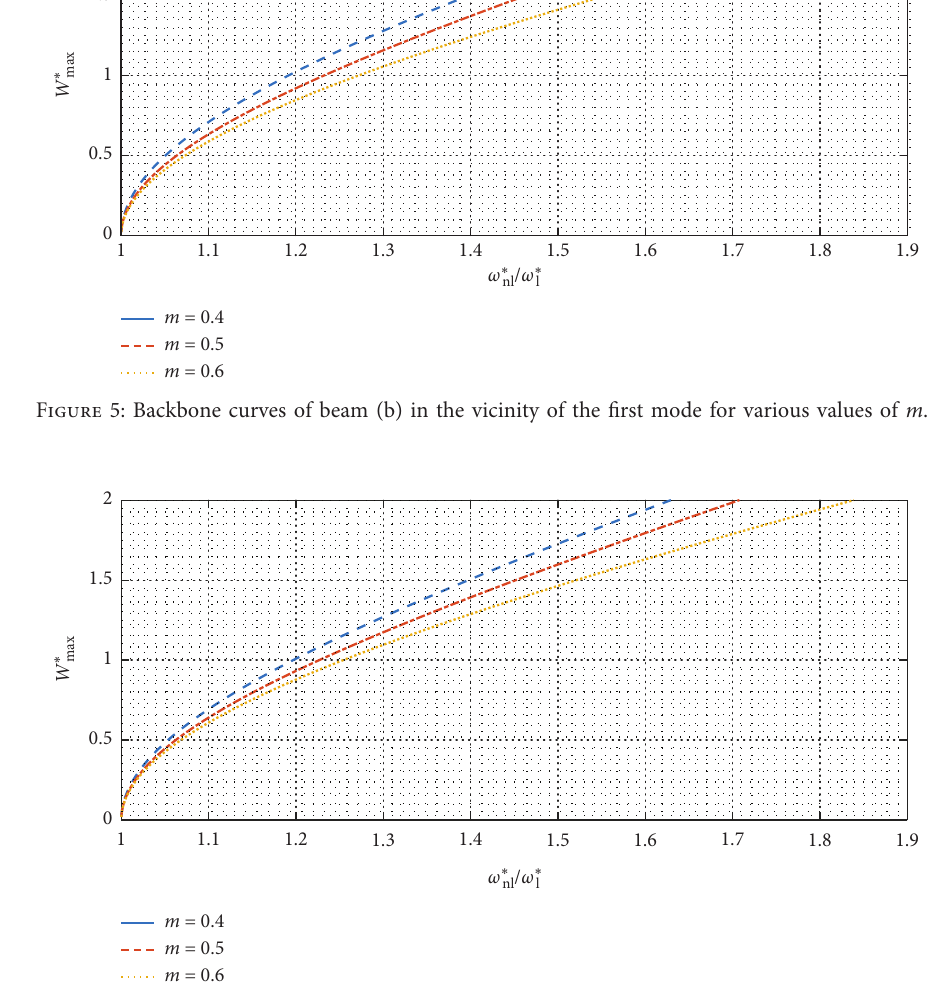
Figure 6: Backbone curves of beam (c) in the vicinity of the first mode for various values of m